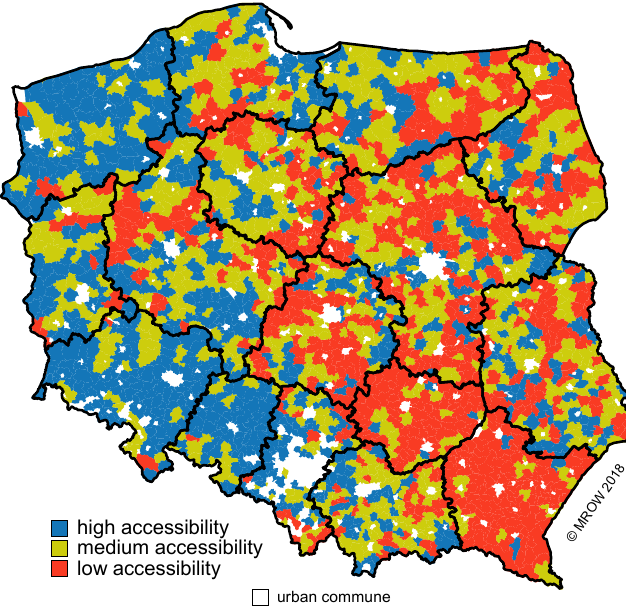
Figure 5. Internet accessibility rate in rural areas 4 . Source: own work based on UKE data.